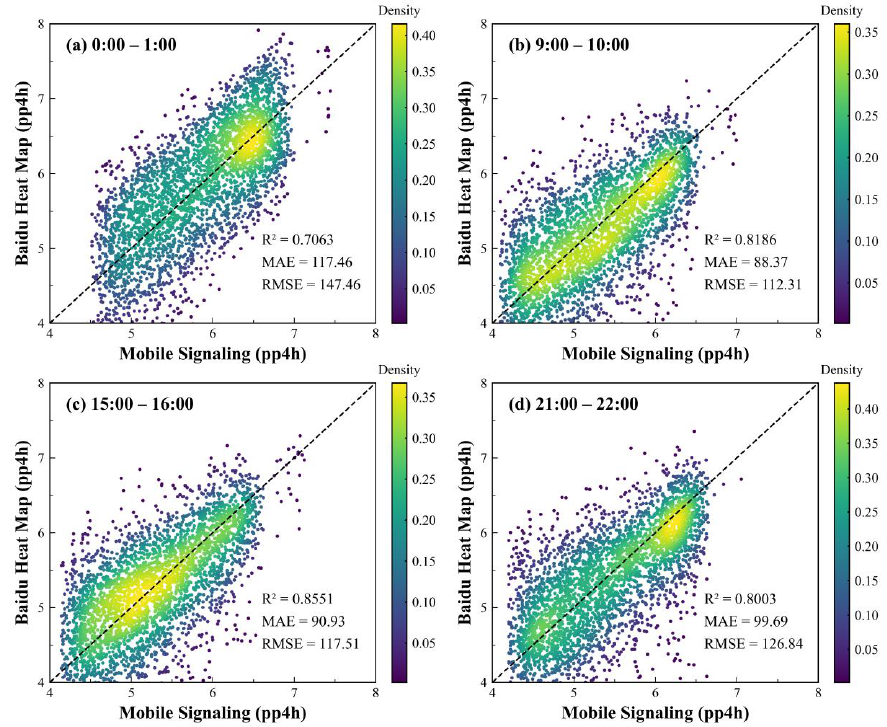
Figure 6. Scatterplots of the Baidu heat map population density and the mobile signaling population density (total of 5172 pixels). A ln-ln transformation was conducted for the population density. The black dashed line indicates the 1:1 line. pp4 h: persons per 4